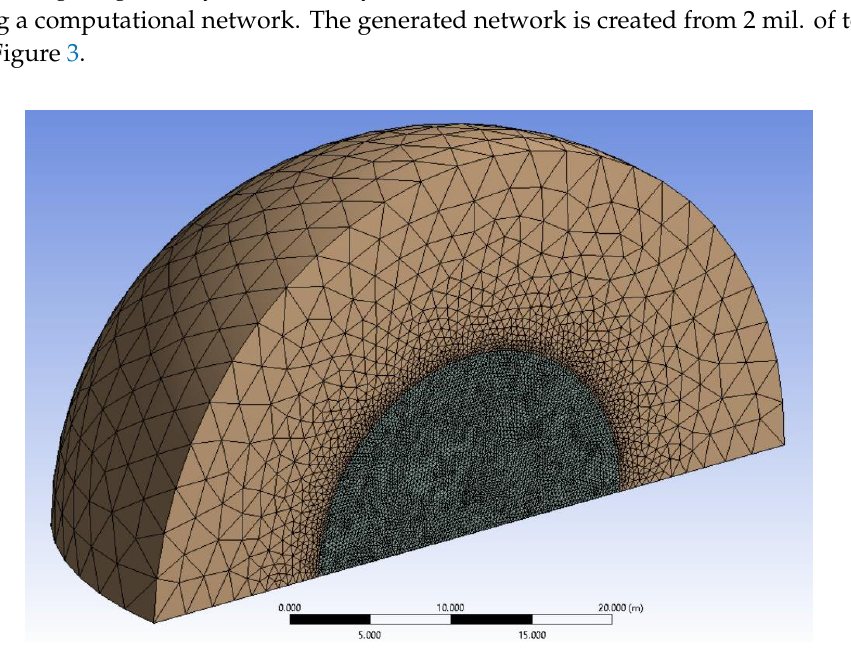
Figure 3. Generated network for the numerical calculation by final volume method.